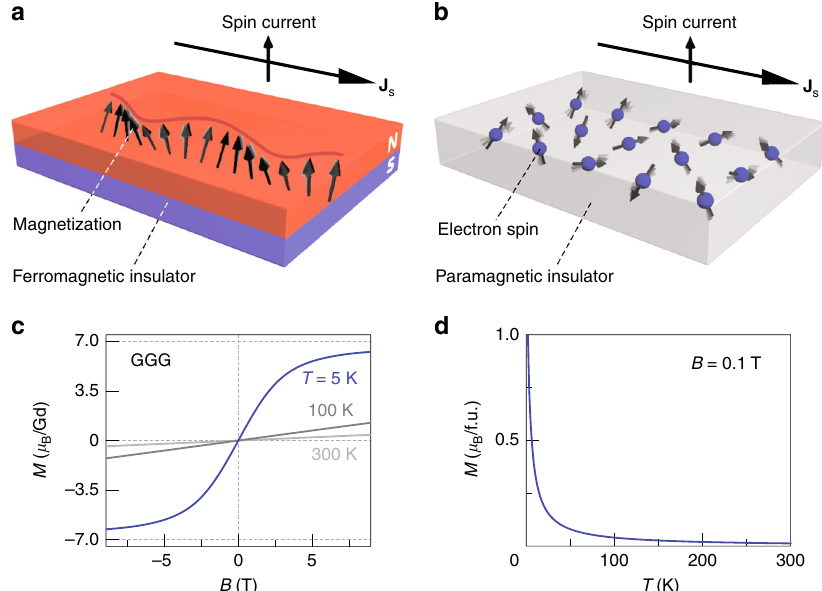
Fig. 1 Concepts of spin current in a ferromagnetic insulator and a paramagnetic insulator and paramagnetism of Gd 3 Ga 5 O 12 . a A schematic illustration of a ferromagnet, in which spins are aligned to form long-range order owing to strong exchange interaction. b A schematic illustration of a paramagnet, in which directions of localized spins are random due to thermal fl uctuations. c Magnetization M as a function of the applied magnetic fi eld B at 5 K, 100 K, and 300 K. The saturation magnetization of GGG is ∼ 7 μ B per Gd 3 + at 5 K. d The temperature dependence of the magnetization of GGG at B = 0.1